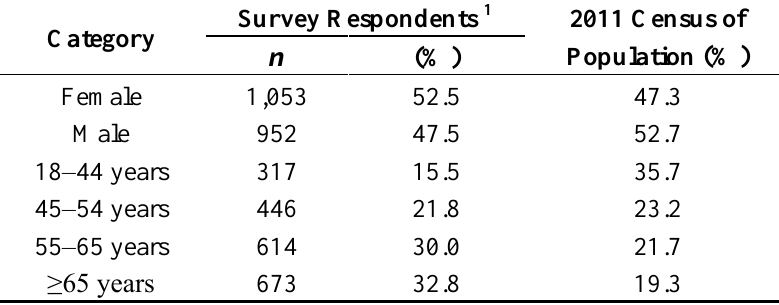
Table 2. Comparison of frequency of key demographic variables in the survey sample population and the Statistics Canada 2011 Census of Population for the rural Census Subdivisions included within the survey